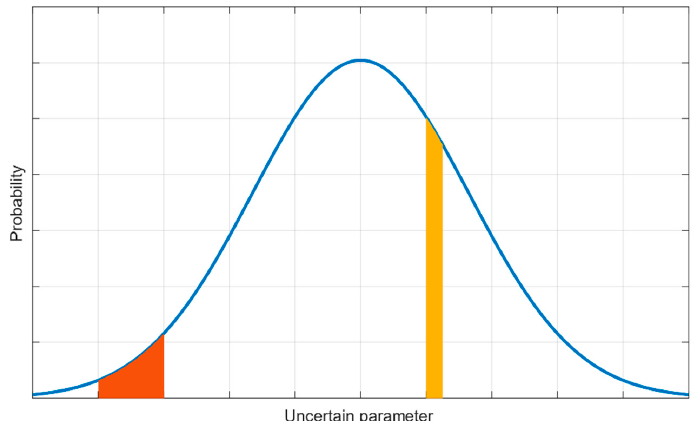
Figure 3. Stochastic flexibility index SF representation on a Normal Probability Distribution Func- tion (PDF).